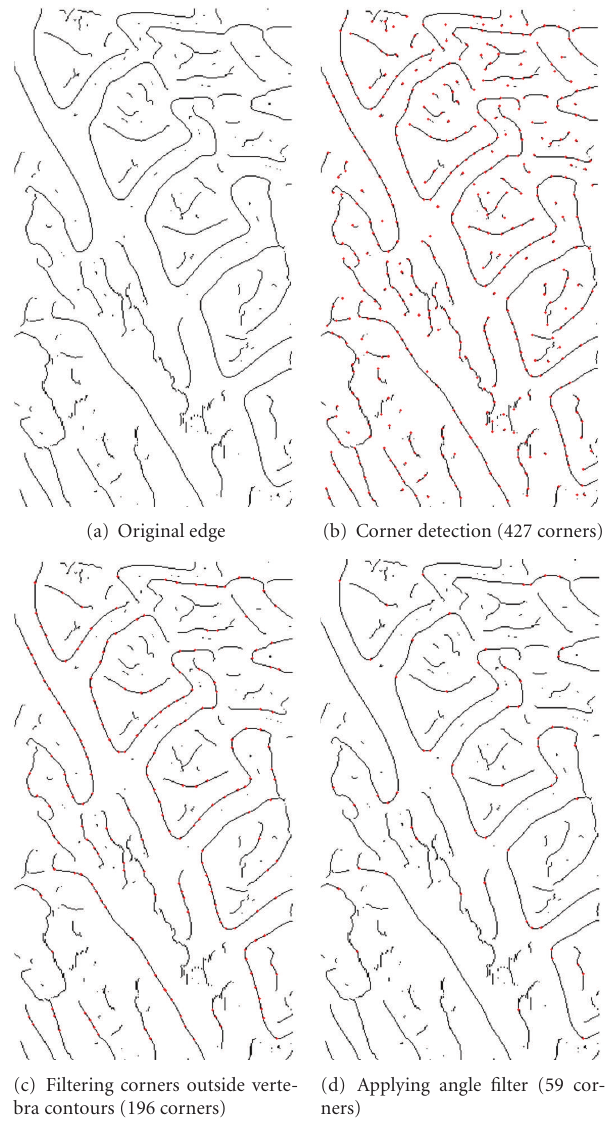
Figure 6: Illustration of the e ff ect of filtering out corners neighboring a contour (b) and the filtering of false corners